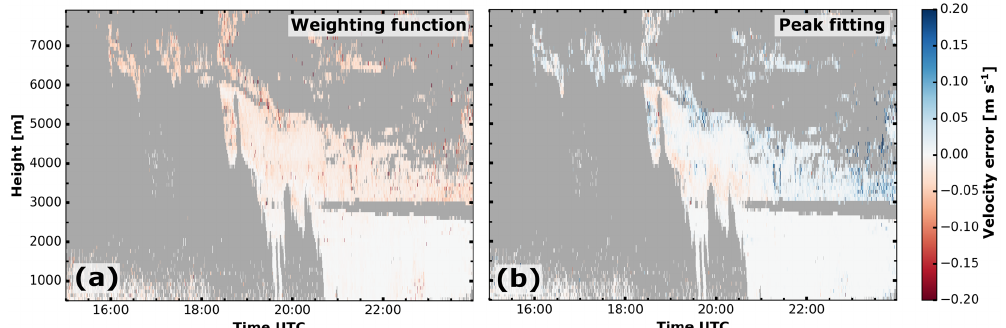
Figure 15. Error estimate for the weighting function (a) and the peak fitting (b) methods during the period covered in case study 1 (Sect. 5.1). Areas where no error estimate is possible are marked in